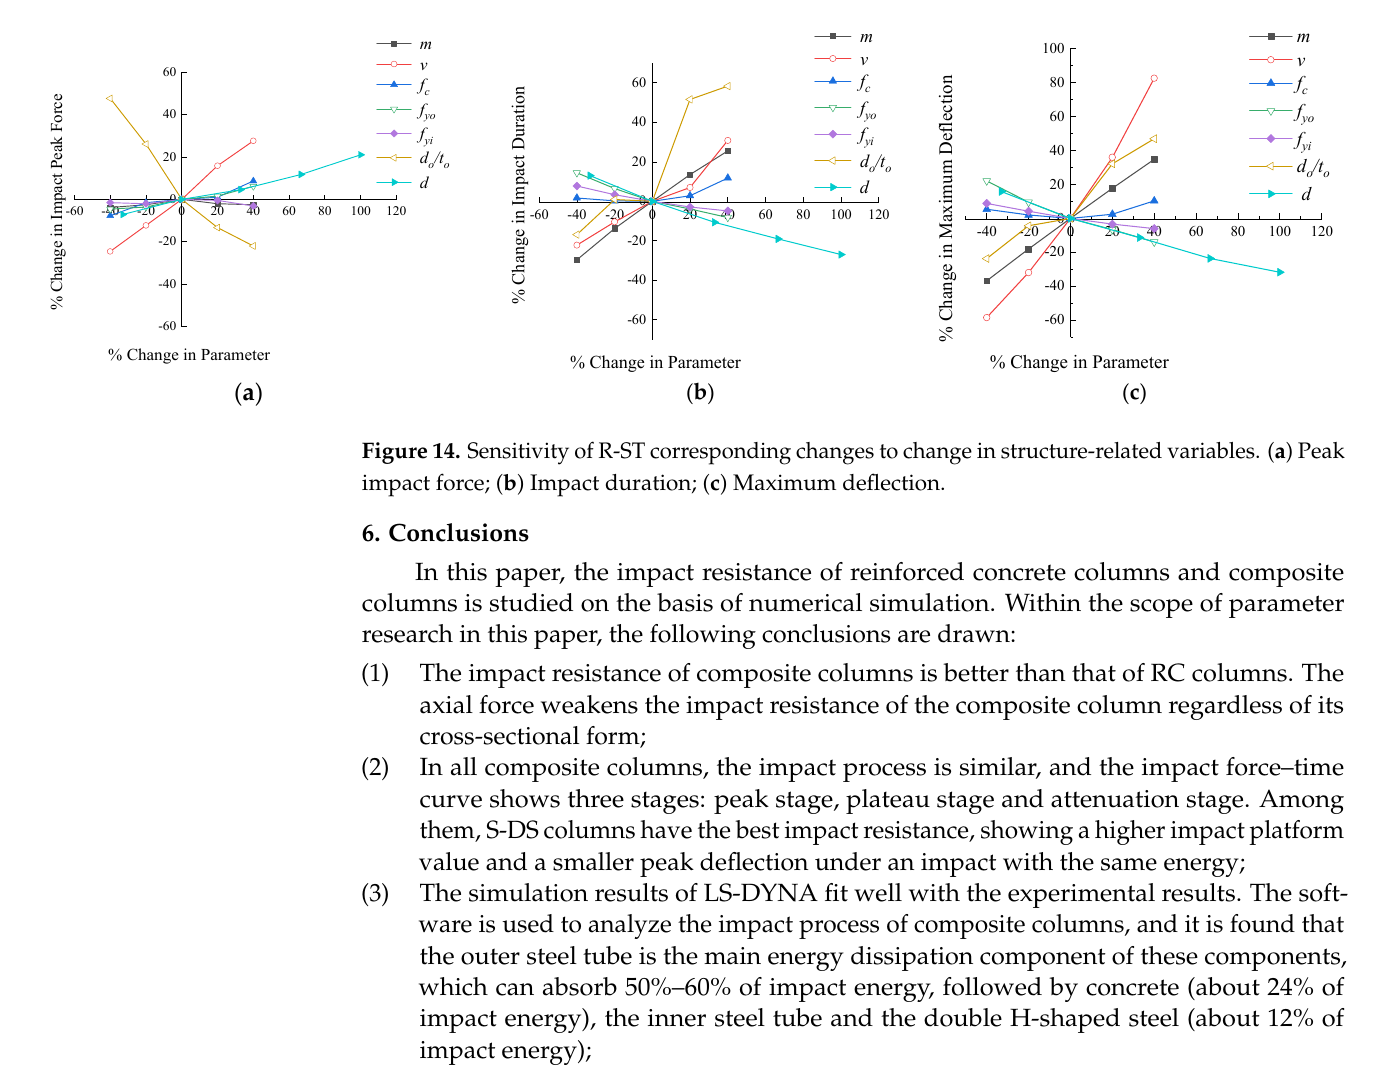
( c ) Figure 13. Sensitivity of S-ST corresponding to changes in structure-related variables. (( a ) Peak impact force; ( b ) Impact duration; ( c ) Maximum deflection. Figure 14 shows the changes in energy dissipation of R-ST columns under various